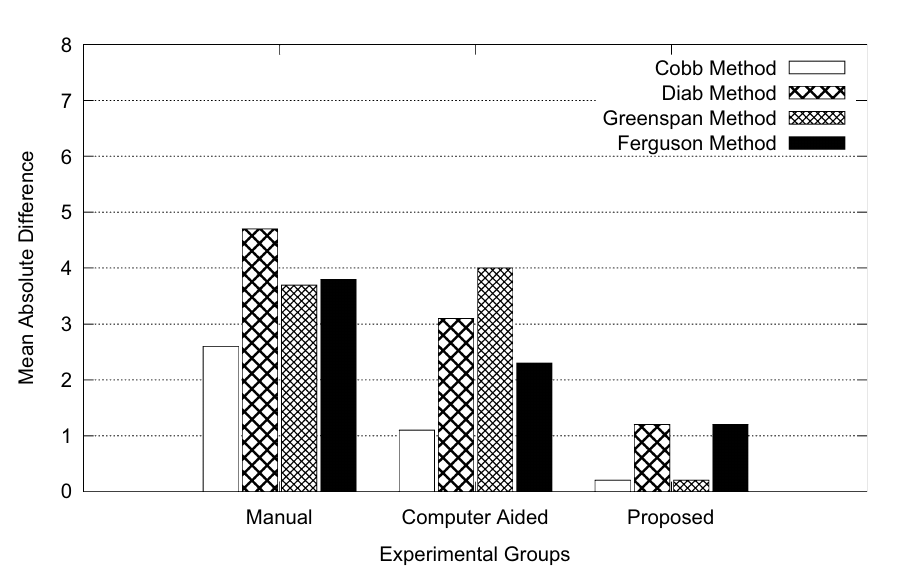
Figure 8. Type IV (a) mean absolute difference (MAD) in inter observer